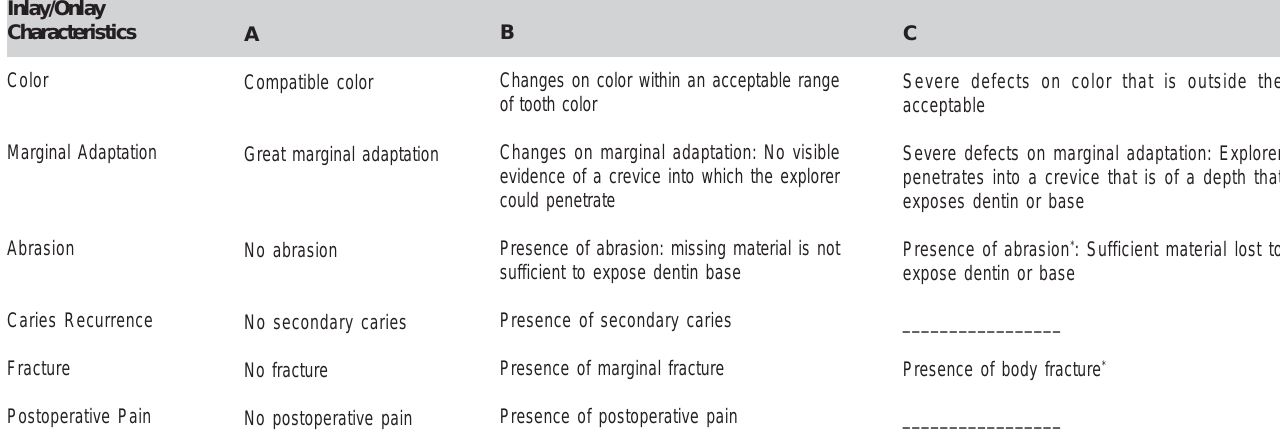
Table 1. Criteria used for the clinical evaluation of the ceramic